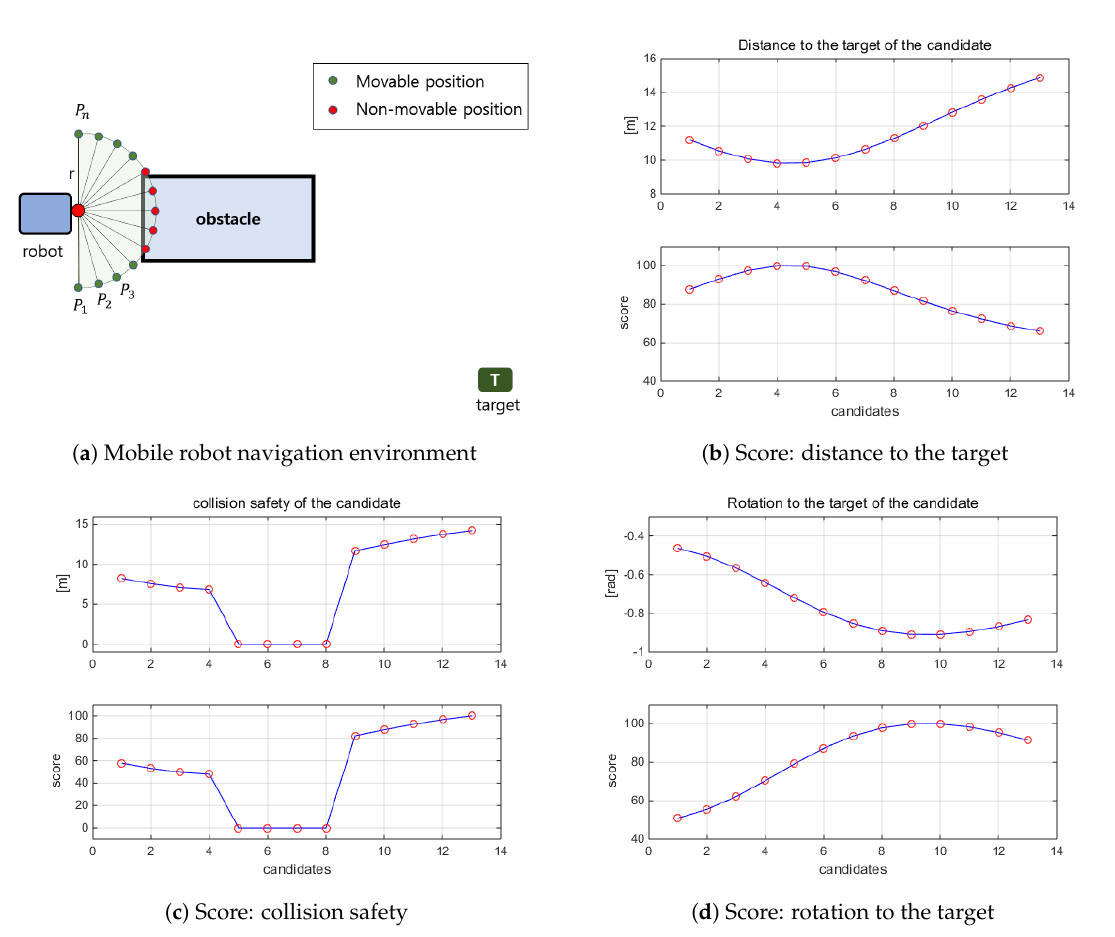
Figure 4. Candidate evaluation based on objectives.